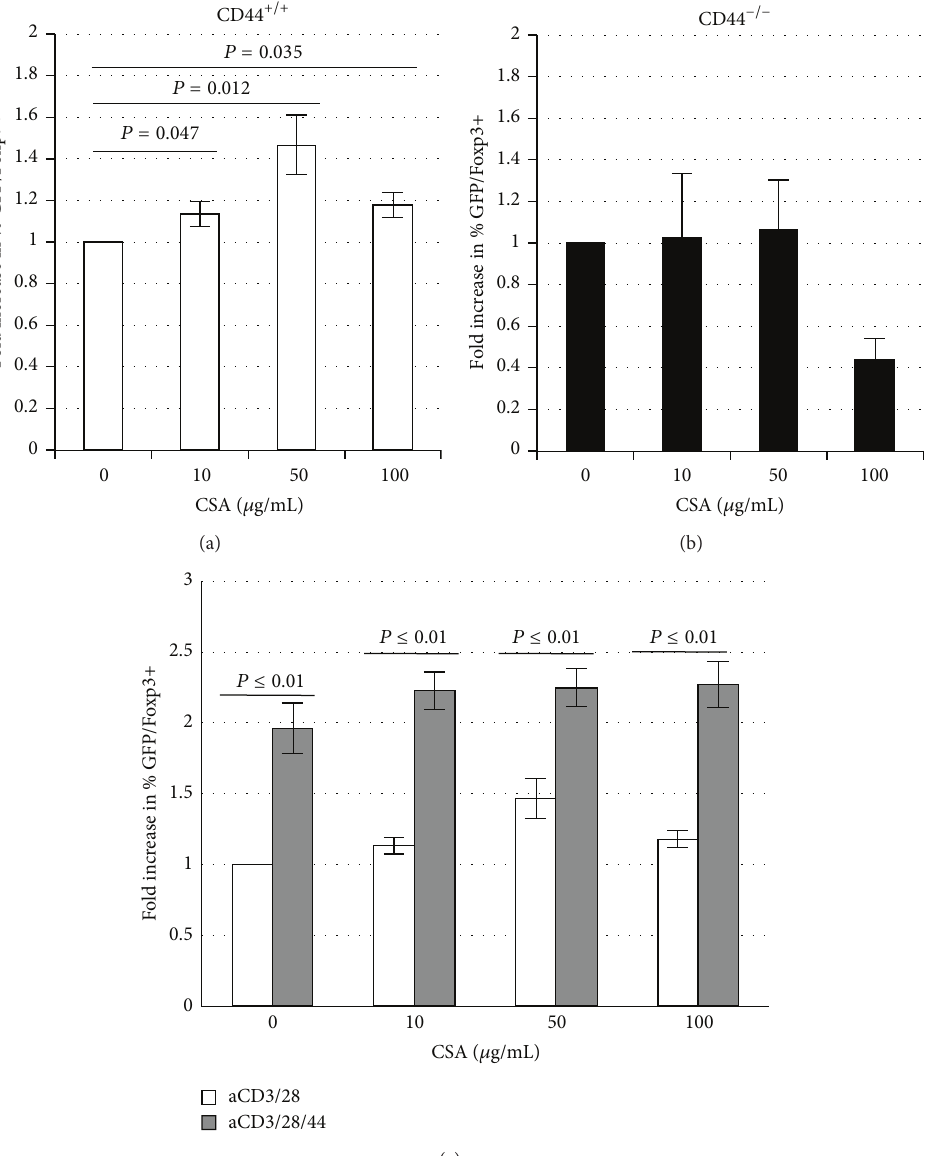
Figure 1: CSA increases Treg percentages in a CD44 dependent manner. Fold increase (FI) in the percentage of GFP/Foxp3+ cells of (a) CD44- containing or (b) CD44-deficient, murine CD4+ T cells after 3 days of culture in the settings of anti-CD3 and anti-CD28 with or without CSA in various concentrations. (c) Fold increase (FI) in percentage of GFP/Foxp3+ cells after 3 days of culture in the setting of anti-CD3 and anti-CD28 alone or in conjunction with anti-CD44 Ab. 𝑛 = 5 replicate